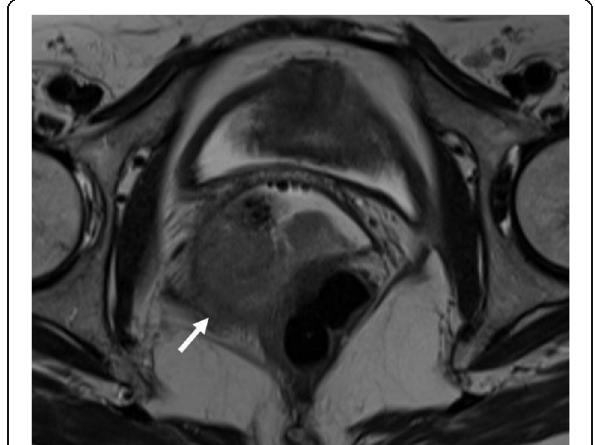
Fig. 2 Axial T2W MRI showed irregular tumor signal extending to parametrium (parametrial invasion) (arrow)